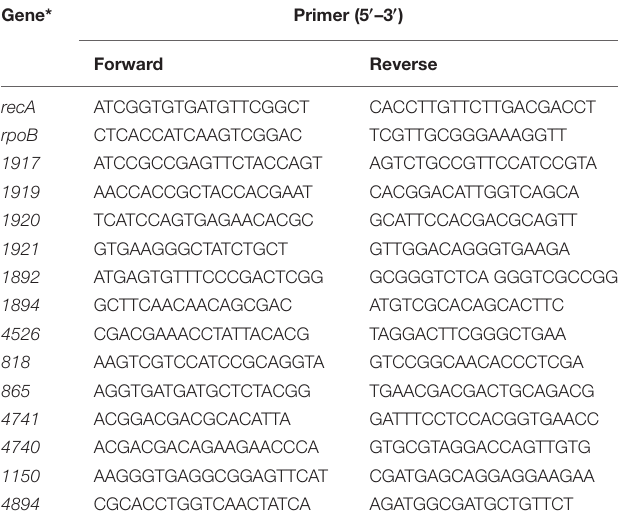
TABLE 1 | Primers used for RT-PCR.